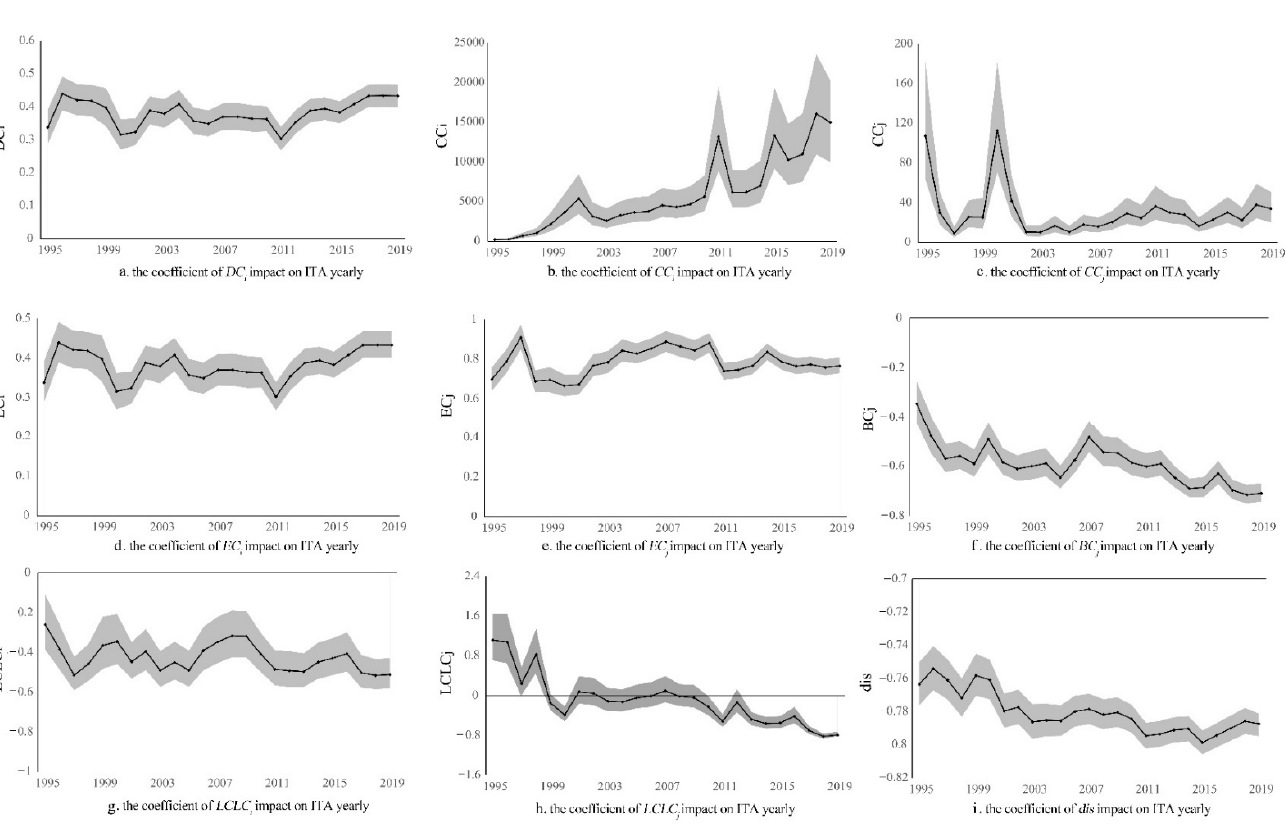
Figure 8. The coefficients of all individual measurements on performance indicator from 1995 to 2019. Table 5. The estimation of variables’ effect.